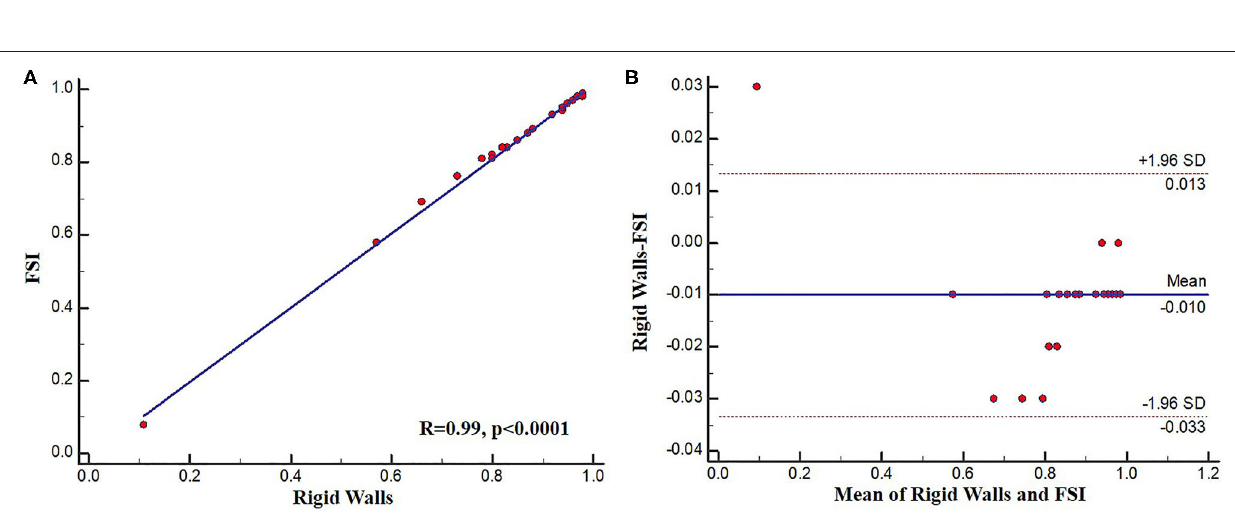
Frontiers in Cardiovascular Medicine |